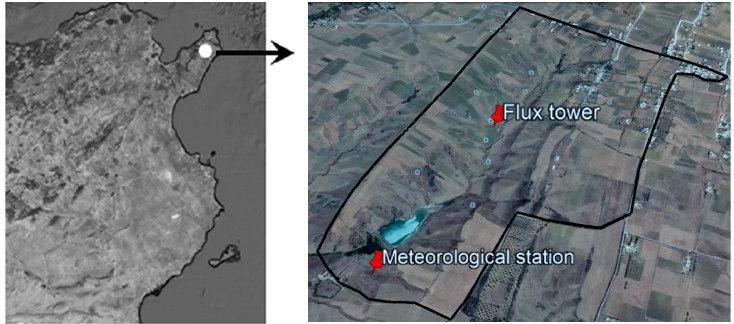
Figure 1. The Kamech watershed. ( Left ) localization of the Kamech watershed within the Cap Bon peninsula, north-eastern Tunisia. ( Right ) aerial map of the Kamech watershed with the localization of the flux tower and of the meteorological station.